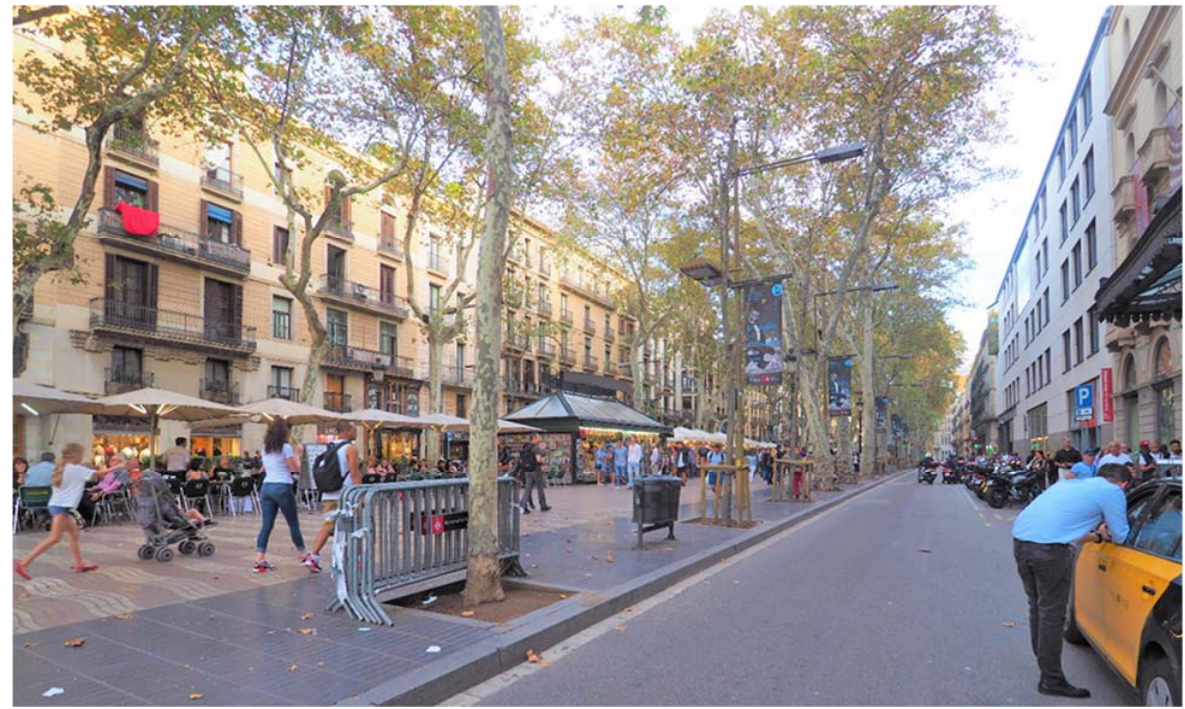
Figure 9. Las Ramblas, Barcelona. Photo by N. H. Buras, 2017.